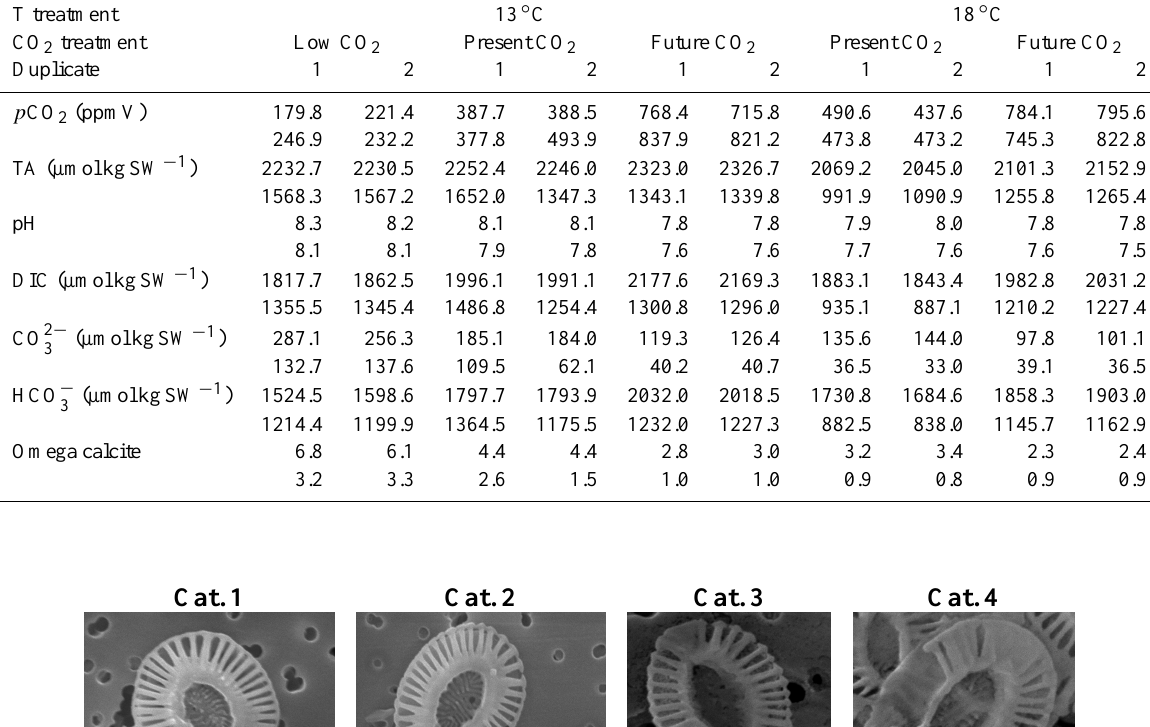
Table 1. Parameters of the Dissolved Inorganic Carbon (DIC) chemistry in E. huxleyi culture experiments corresponding to different tem- perature ( T ) and CO 2 treatment. For each parameters, the values in the first row represent the initial condition and the numbers in the second row represent the parameter at the end of the culture experiments. For p CO 2 , the numbers in the third row represent the average value.